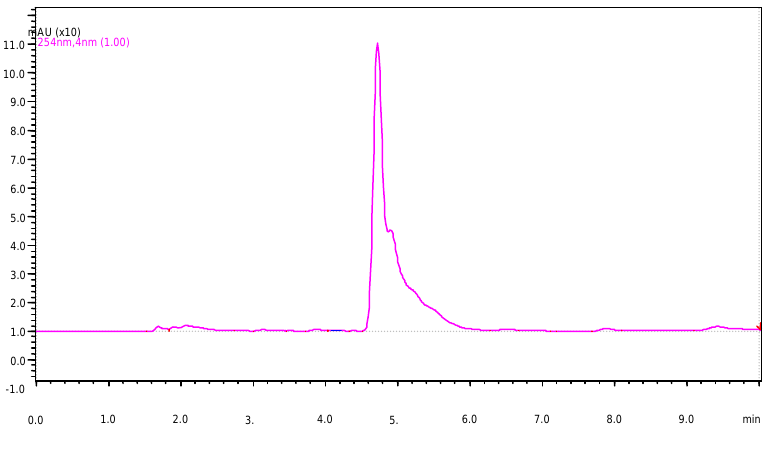
Figure 2. Typical chromatogram of a carbaryl standard injected at 60 µg/mL (Retention time 4.73